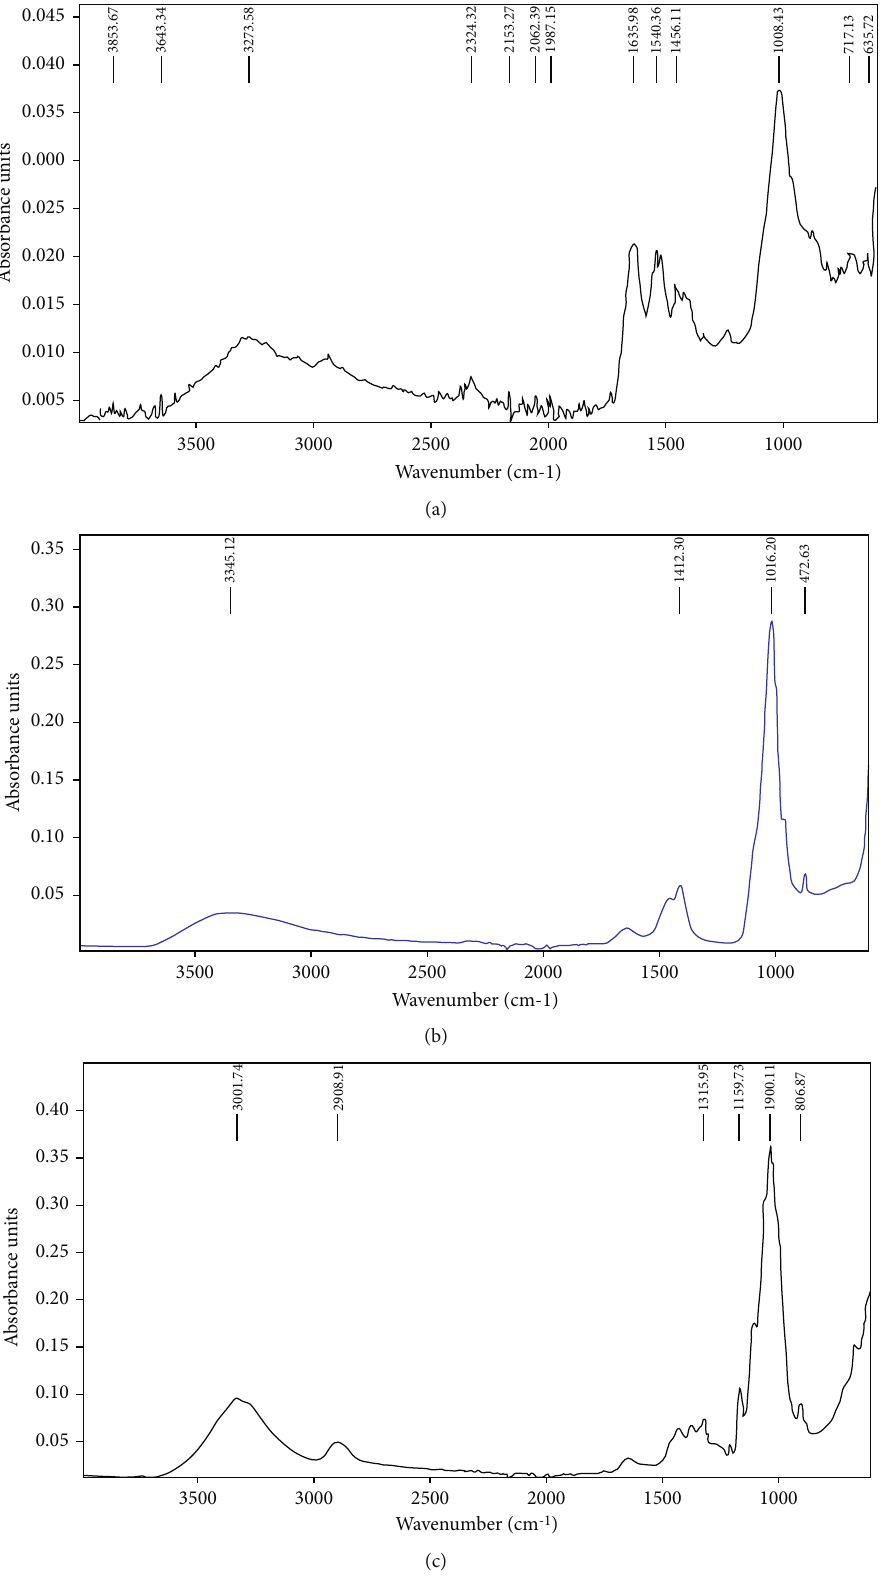
Figure 3: FTIR analysis of (a) chitin, (b) chitosan, and (c) chitosan-composite membrane showing the position of functional